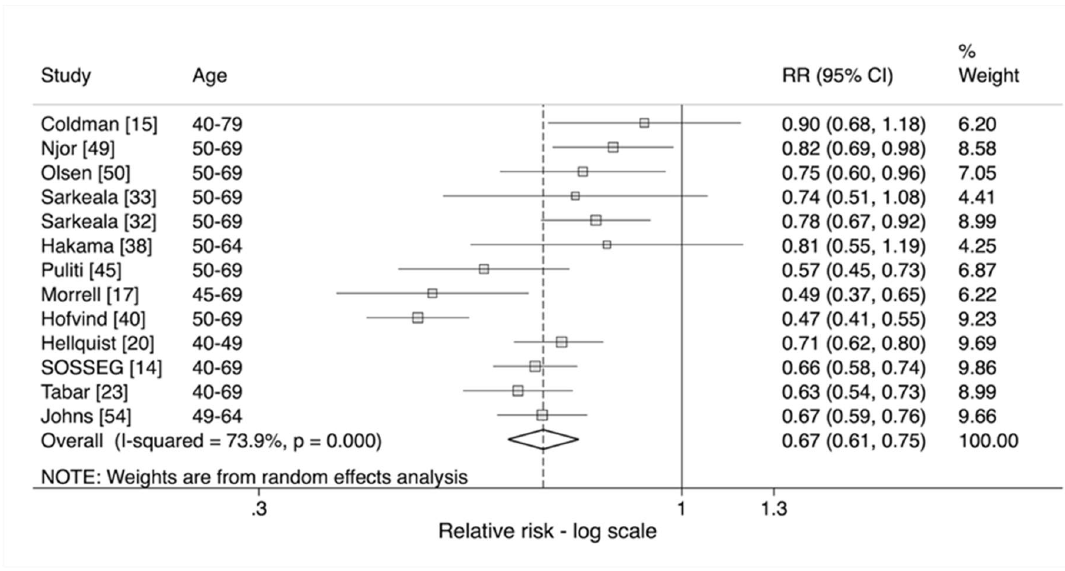
Figure 3. Estimated effect of attendance adjusted for self-selection on risk of breast cancer mortality ( RR 2 ) [14,15,17,20,23,32,33,38,40,45,49,50,54].